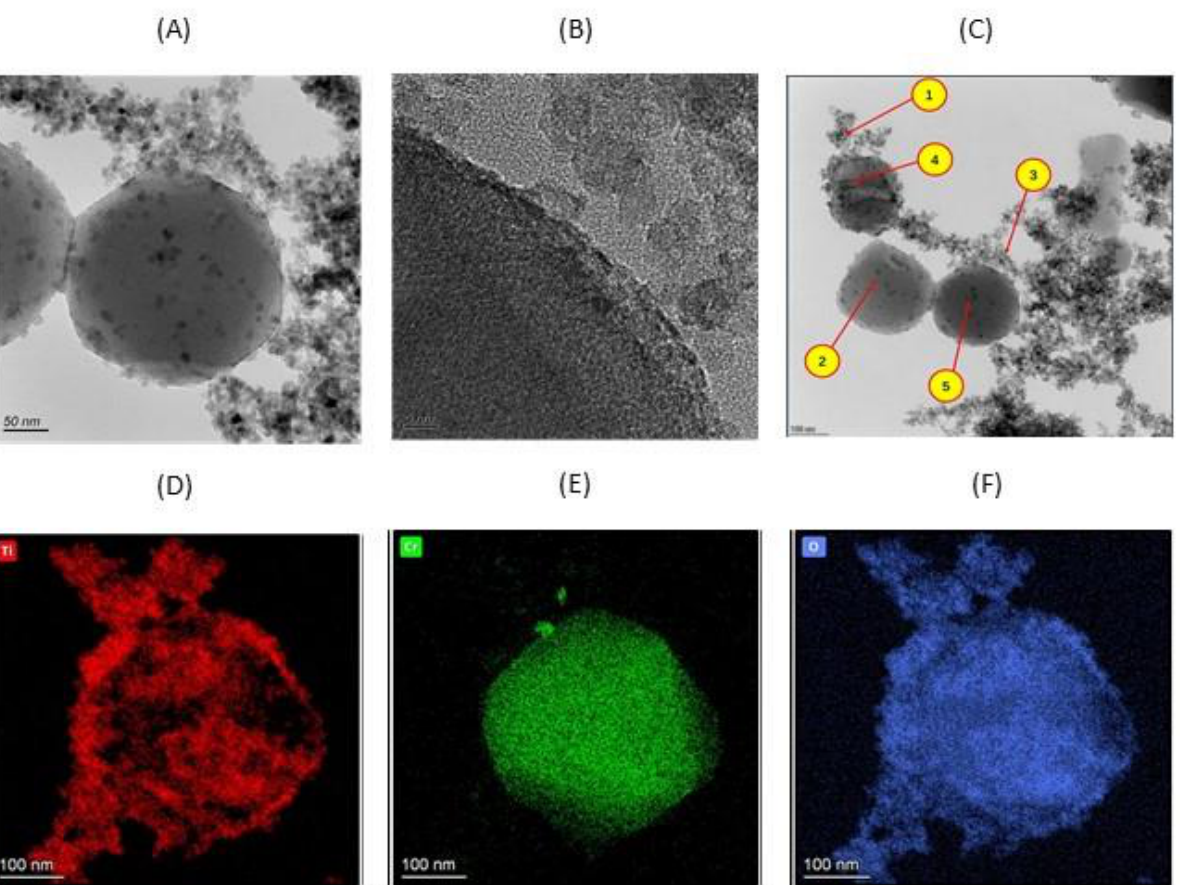
Figure 1. ( A ) Transmission electron microscopy (TEM); ( B ) high-resolution transmission electron microscopy (HRTEM); ( C ) transmission electron microscopy energy-dispersive spectroscopy (TEM EDS) point detection, EDS mapping; and the ( D ) Ti, ( E ) Cr, and ( F ) O of the MIL-101(Cr)@TiO 2 com- posite.